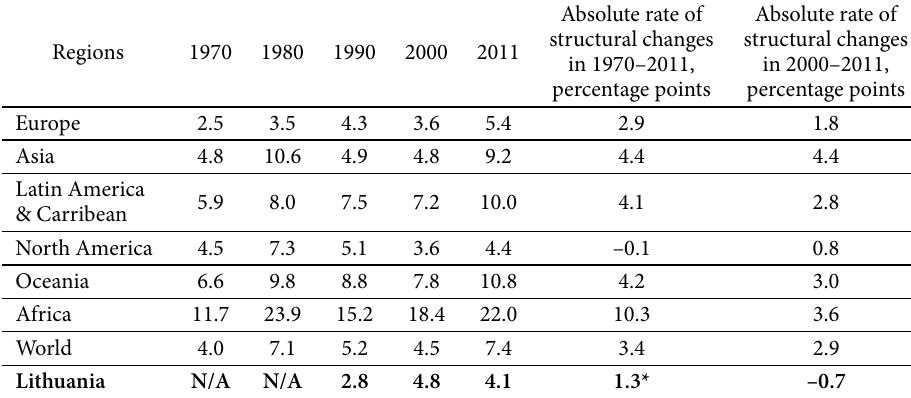
Table 2. Mining and utilities share оf tоtal value added, in percent